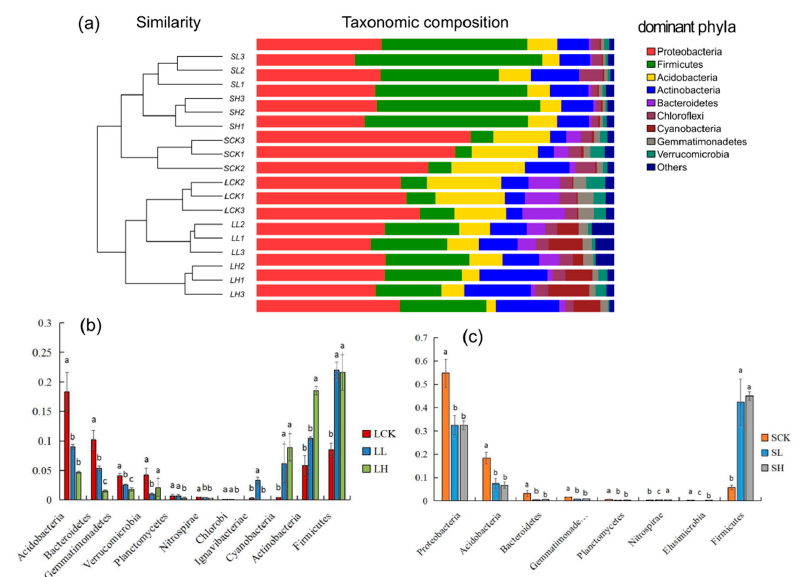
Figure 3. ( a ) Changes in the relative abundances of bacterial dominant phyla. ( a ) Clustering tree of bacterial dominant phyla, and others includes phyla below 0.1% of relative abundance and the unclassified phyla. It is significantly different in loamy soil ( b ), sandy soil ( c ). Different letters to show statistical significant differences by an ANOVA analysis ( p < 0.05, n = 3).